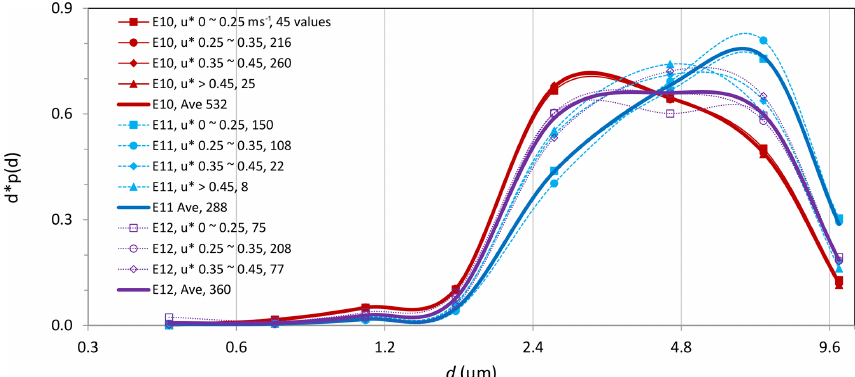
Figure 6. Dust PSD for different u ∗ categories for Event-10, Event-11 and Event-12. Also shown are the PSDs averaged over all u ∗ categories for the individual